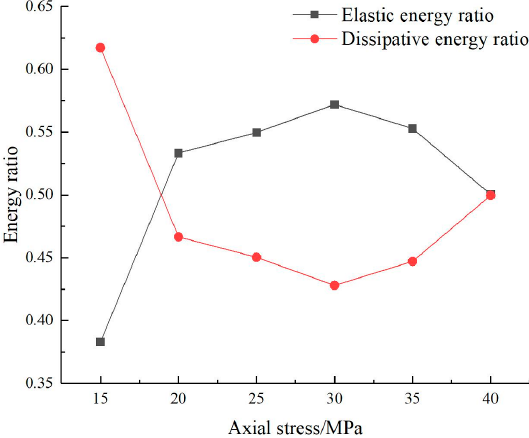
Figure 7. Energy distribution ratio.